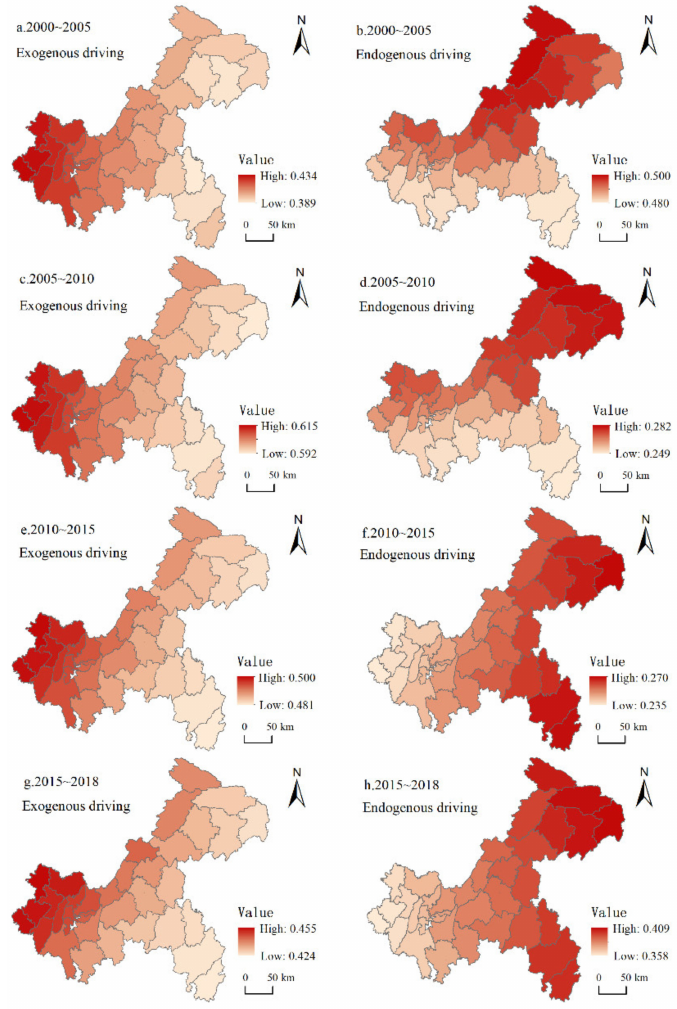
Figure 5. The spatiotemporal differentiation of the influence intensity of endogenous and exogenous driving on rural comprehensive